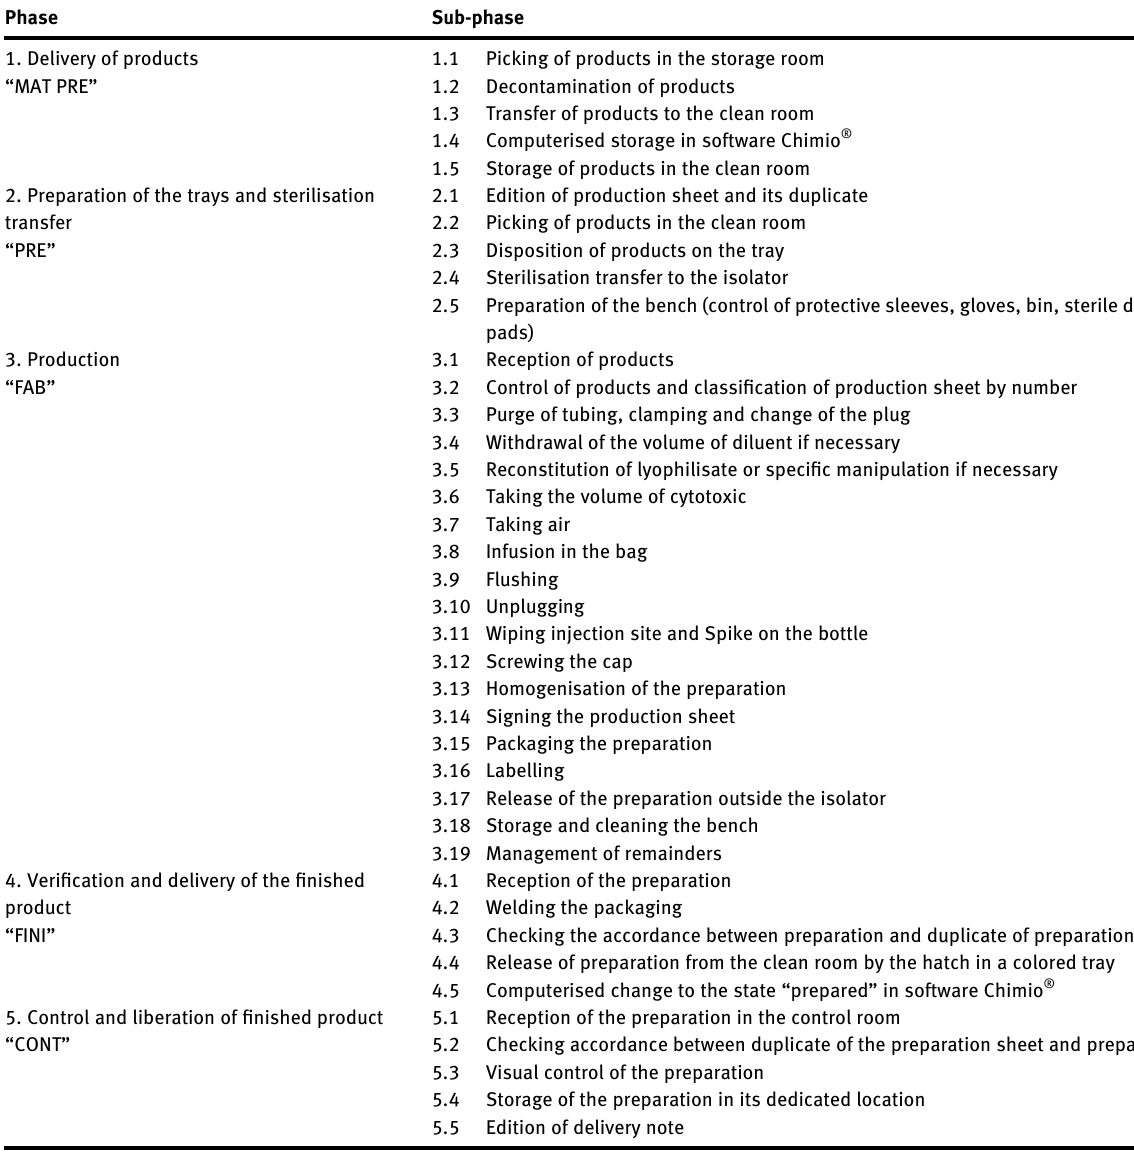
Table  : Modeling of the